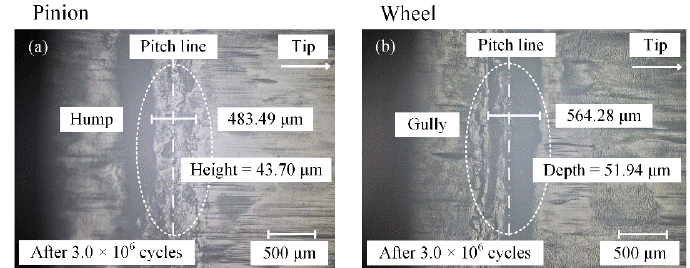
Fig. 10 Wear performance for the 5 N·m load under the dry running